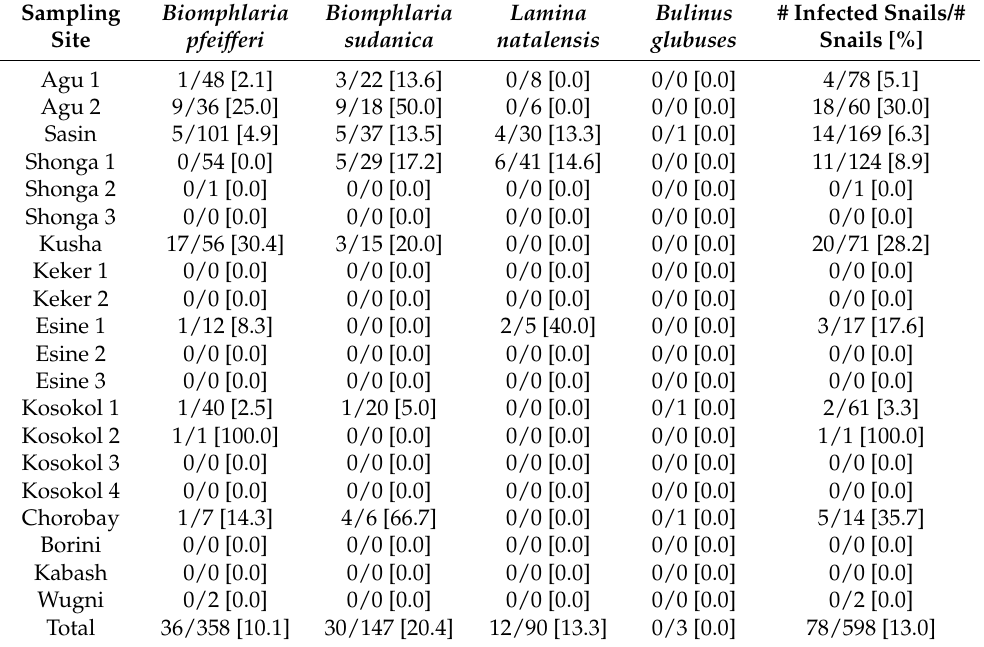
Table 1. Characteristics of the collected snails across the sampling sites n = 598.